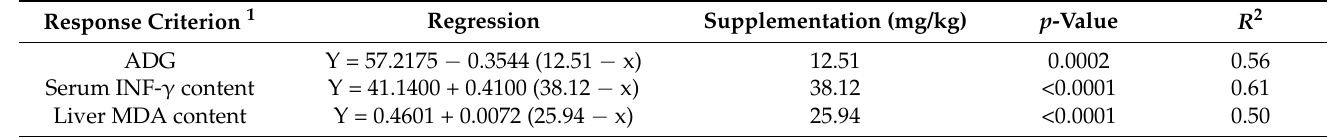
Table 4. Vitamin E supplementations of male Jiangnan white goslings from 1 to 28 d of age based on broken-line regression